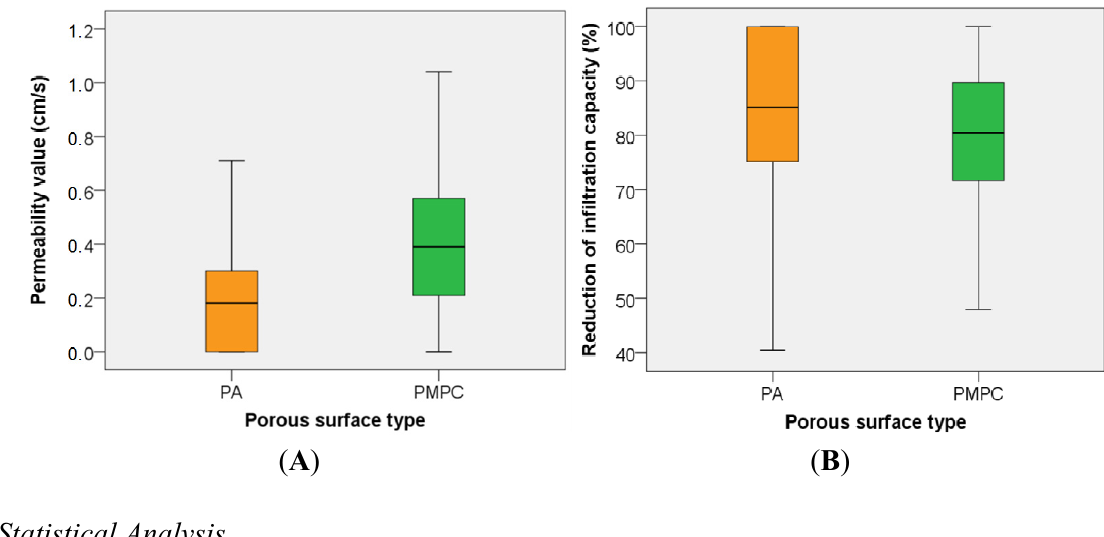
Figure 4. Box-plots of the average values of permeability ( A ) and the reduction of the infiltration capacity ( B